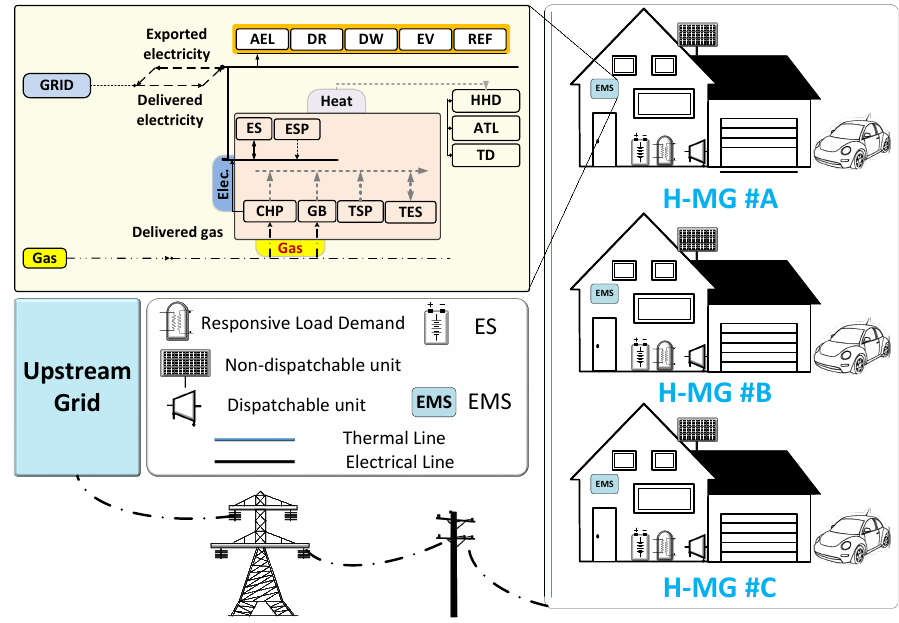
Figure 1. A schematic of the general